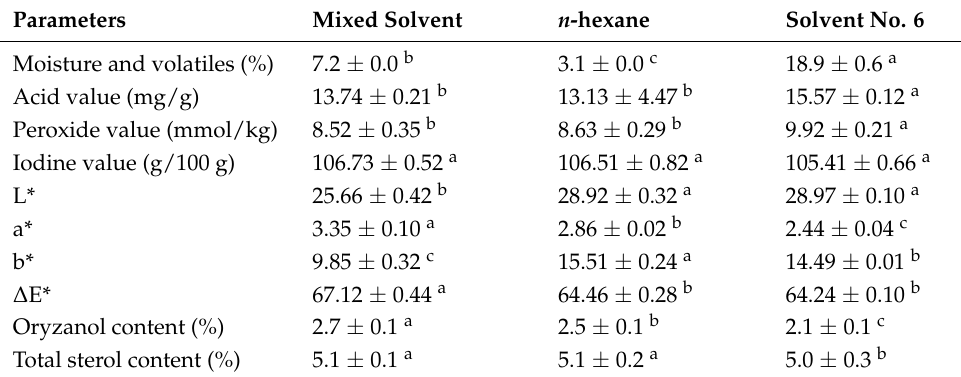
Table 4. Physicochemical properties of RBO extracted using different